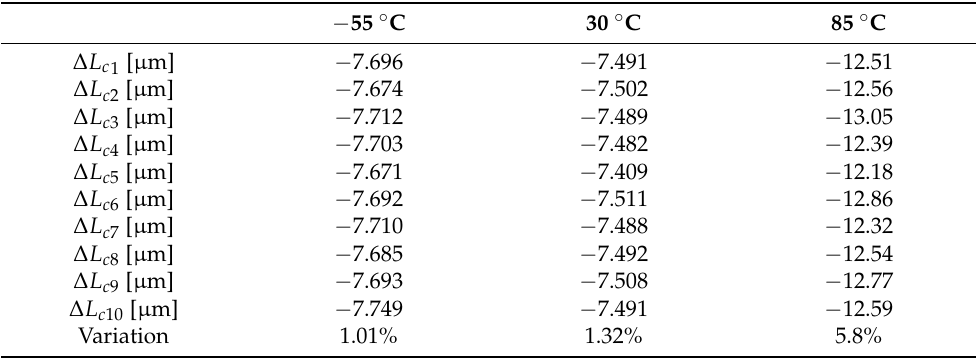
Table 3. Results of thermal deformation of